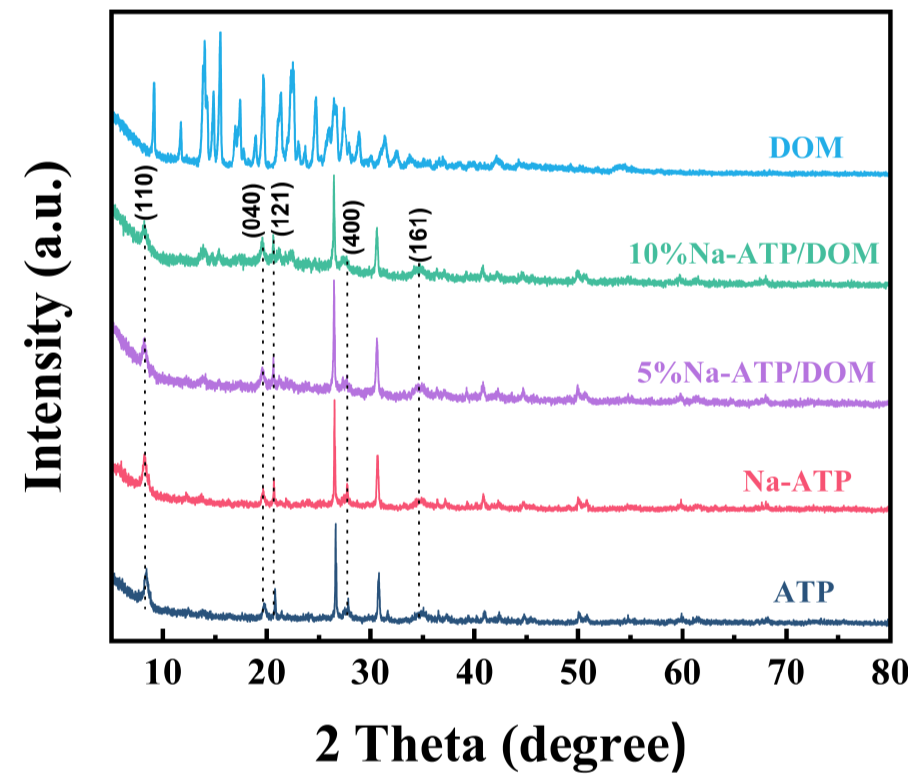
Figure 3. XRD curves of ATP, Na-ATP, DOM, 5% Na-ATP/DOM and 10% Na-ATP/DOM.